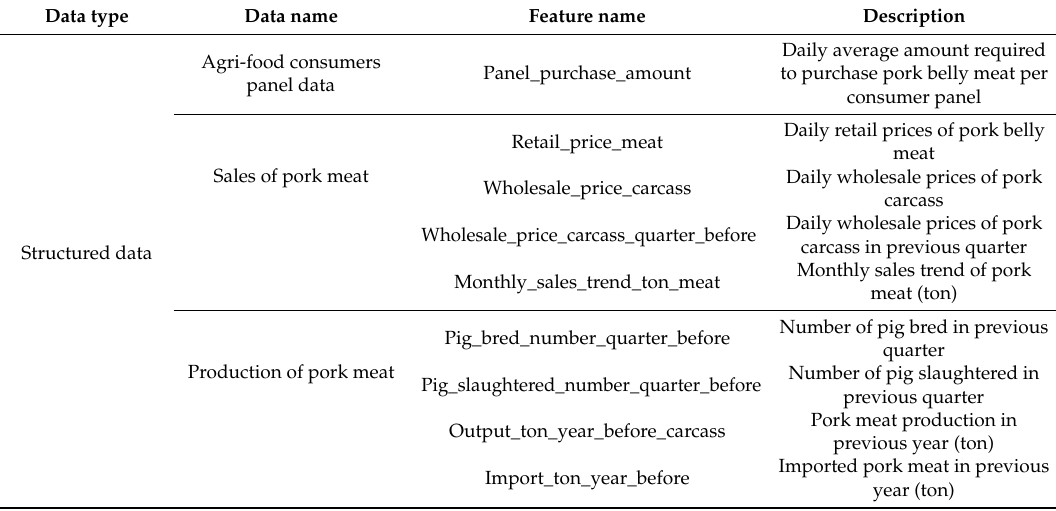
Table 1. List of features of structured data used in the study.